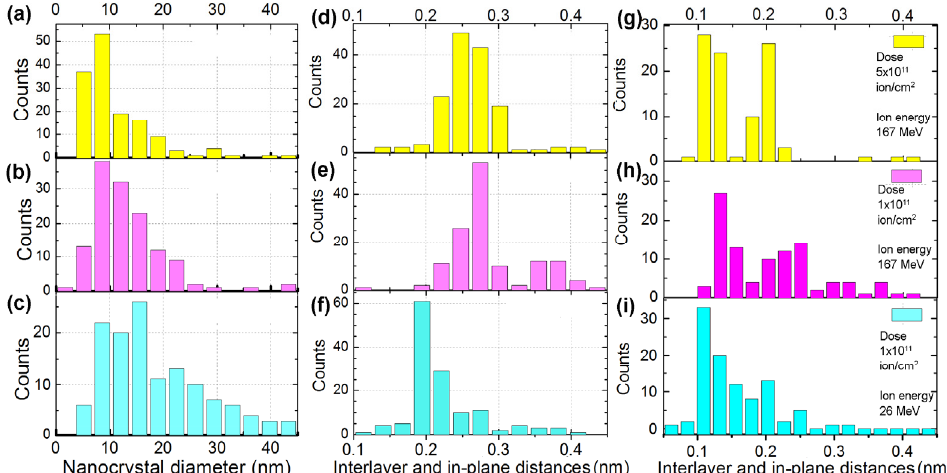
Figure 4. The average nanocrystal diameter ( a – c ), and interlayer and in-plane distance ( d – i ) distri- butions for the FLG CVD-films irradiated with Xe ions. The ion energy is 167 MeV for ( a , b , d , e , g , h ) and 26 MeV for ( c , f , i ). For ( a , d , g ) the dose is ~5 × 10 11 and ~1 × 10 11 for ( b , c , e , f , h , i